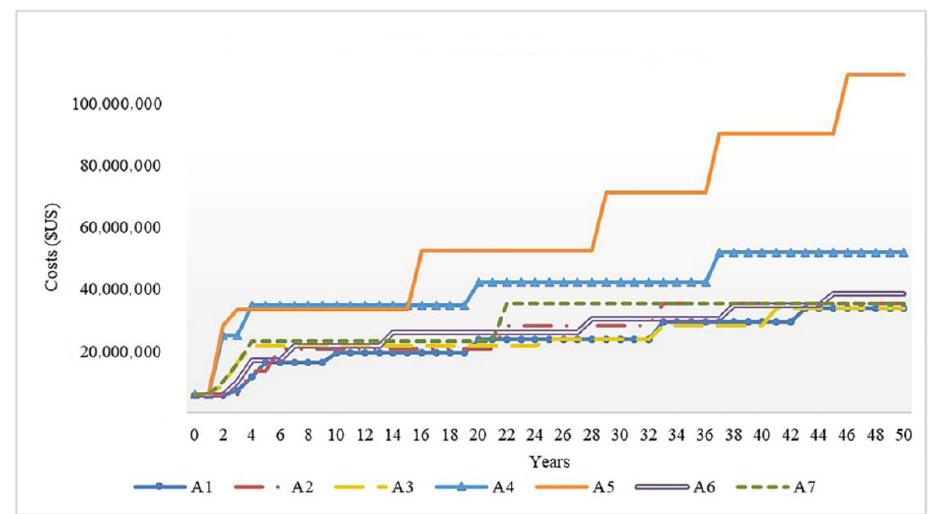
Figure 7. Estimated annual treatment costs by alternative. Table 4. Costs summary by alternatives.